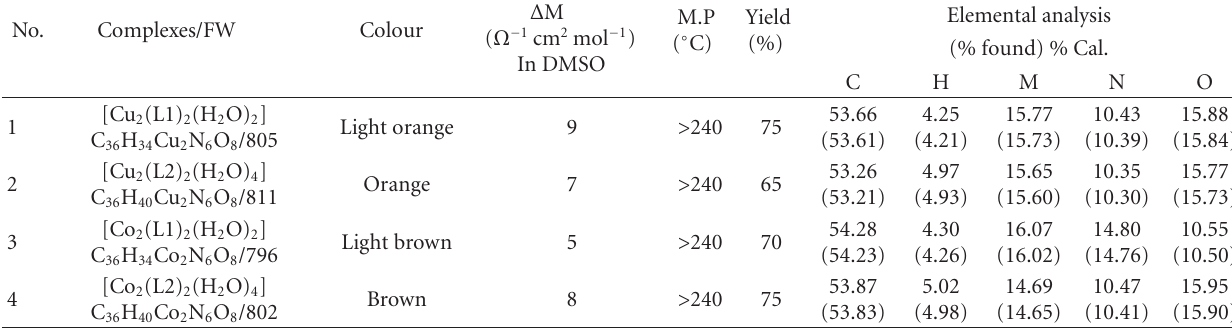
Figure 1: Structure of the ligands L1 and L2. Table 1: Analytical and physical data of all the